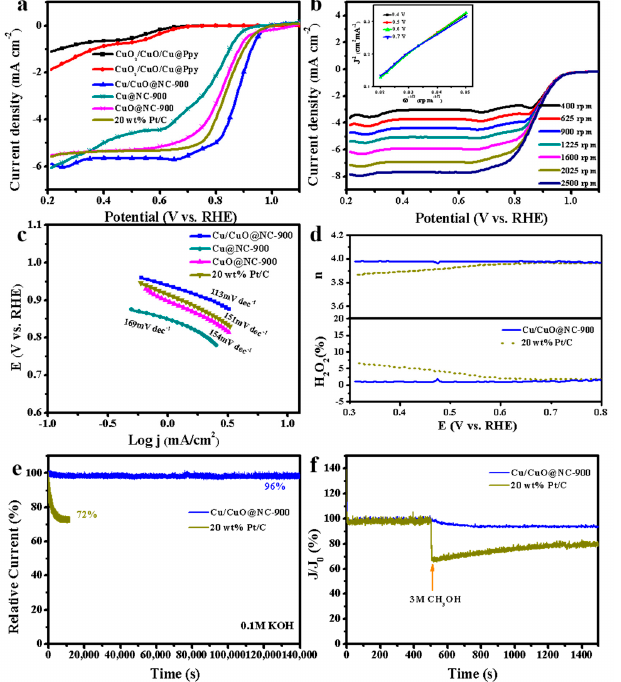
Figure 5. ( a ) RRDE curves of Cu 2 O/CuO/Cu@Ppy, Cu 2 O/CuO@Ppy, Cu/CuO@NC-900, Cu@NC-900, CuO@NC-900, and 20 wt% Pt/C at a sweep rate of 5 mV s − 1 and a rotation speed of 1600 rpm; ( b ) LSV curves of Cu/CuO@NC-900 catalyst at a sweep rate of 5 mV s − 1 and different rotation speeds ranging from 400 to 2500 rpm, and the Koutecky–Levich plots (insets); ( c ) the corresponding Tafel curves derived from ( a ); ( d ) electron transfer number n and H 2 O 2 yield of Cu/CuO@NC-900 and commercial Pt/C; ( e ) current versus time (i–t) chronoamperometric response of the Cu/CuO@NC-900 and Pt/C at 0.7 V in O 2 -saturated 0.1 m KOH at 200 rpm; ( f ) the stability evaluation for Cu/CuO@NC-900 and Pt/C catalysts in O 2 -saturated 0.1 M KOH with the injection of 3 M methanol.